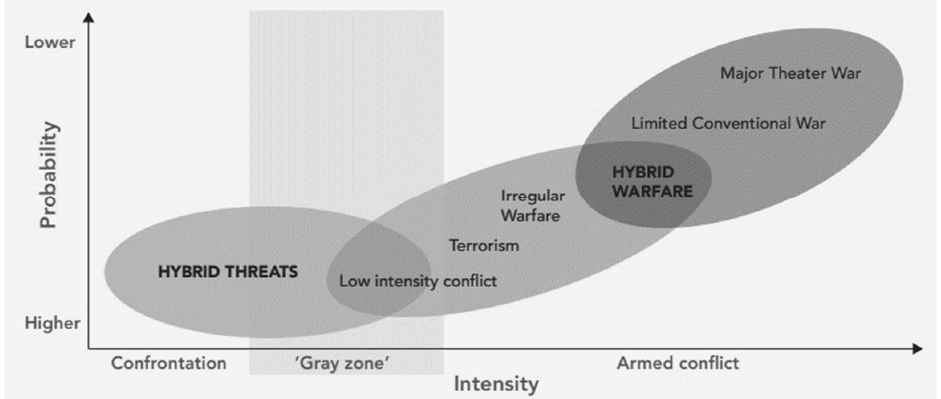
Figure 4. Probability ‐ intensity relations across the continuum of conflict. Source: Monaghan (2019).